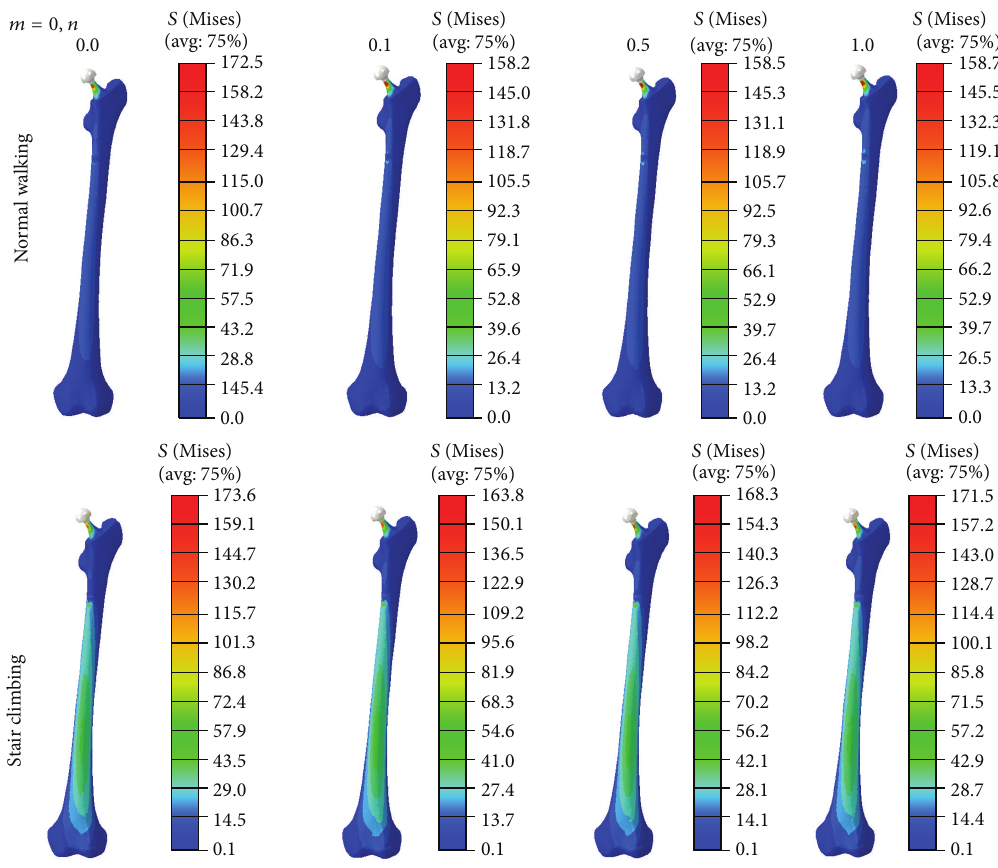
Figure 6: The von Mises stress distribution in the femur due to inserting radial noncemented prosthesis, under normal walking and stair climbing